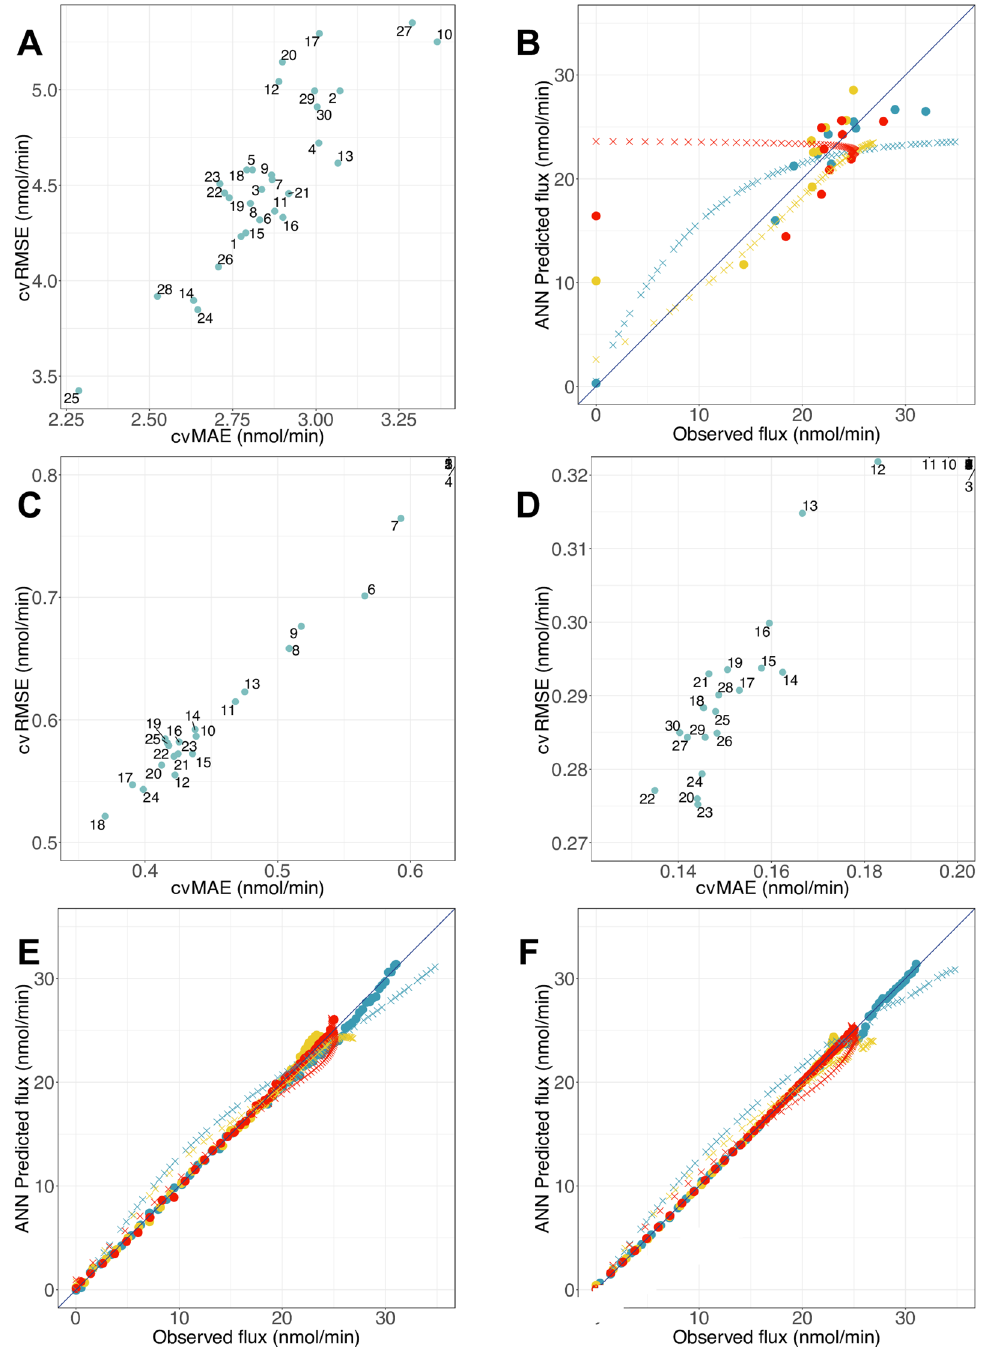
Figure 4. ANN model selections and flux predictions. ( A ) cvRMSE and cvMAE for the first dataset and using NeuralNet package and log activation function. The numbers represent the number of HUs. ( B ) Flux prediction with the best ANN model with 1 HU. Training: cvRMSE = 4.23 nmol·min −1 , cvMAE = 2.78 nmol·min −1 , cvR 2 = 0.71 and Test: RMSE = 1.56 nmol·min −1 , MAE = 1.24 nmol·min −1 , R 2 = 0.97. ( C , D ) cvRMSE and cvMAE for the second dataset and using NeuralNet package and tanh activation function ( C ) or Nnet package and log activation function ( D ). The numbers represent the number of HUs. ( E ) Flux prediction with the best ANN model using NeuralNet, tanh activation function and 18 HUs for the training set (circles) and test set (crosses). Training: cvRMSE = 0.52 nmol·min −1 , cvMAE = 0.37 nmol·min −1 , cvR 2 = 1 and Test: RMSE = 1.61 nmol·min −1 , MAE = 1.37 nmol·min −1 , R 2 = 0.98. ( F ) Flux prediction with the best ANN model using Nnet, log activation function and 23 HUs for the training set (circles) and test set (crosses). Training: cvRMSE = 0.28 nmol·min −1 , cvMAE = 0.13 nmol·min −1 , cvR 2 = 1 and Test: RMSE = 1.69 nmol·min −1 , MAE = 1.47 nmol·min −1 , R 2 = 0.98. Colored circles/crosses refer to the various levels of enzyme activity: PGAM (blue), ENO (yellow) or PPDK (red) for the training/test